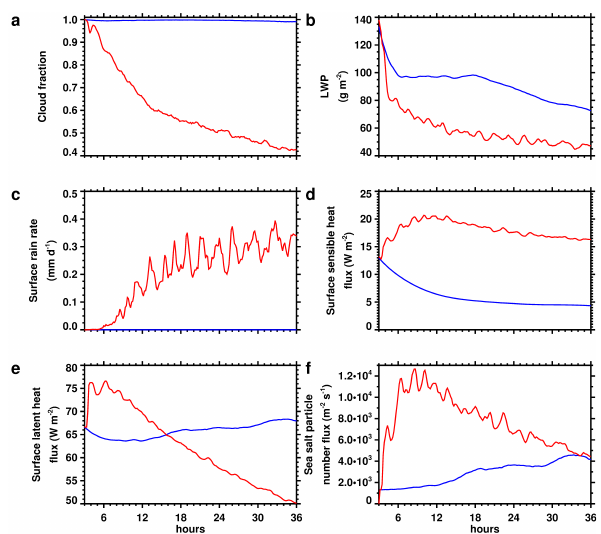
Fig. 3. Domain-averaged time series of selected quantities in simu- lation S • (blue) and S ◦